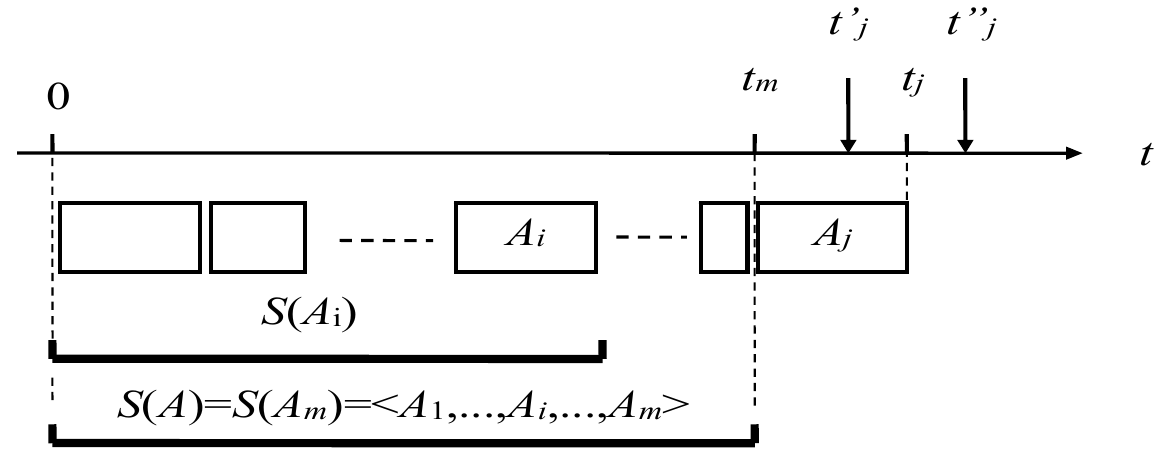
Figure 2. Example sequence of execution tasks.